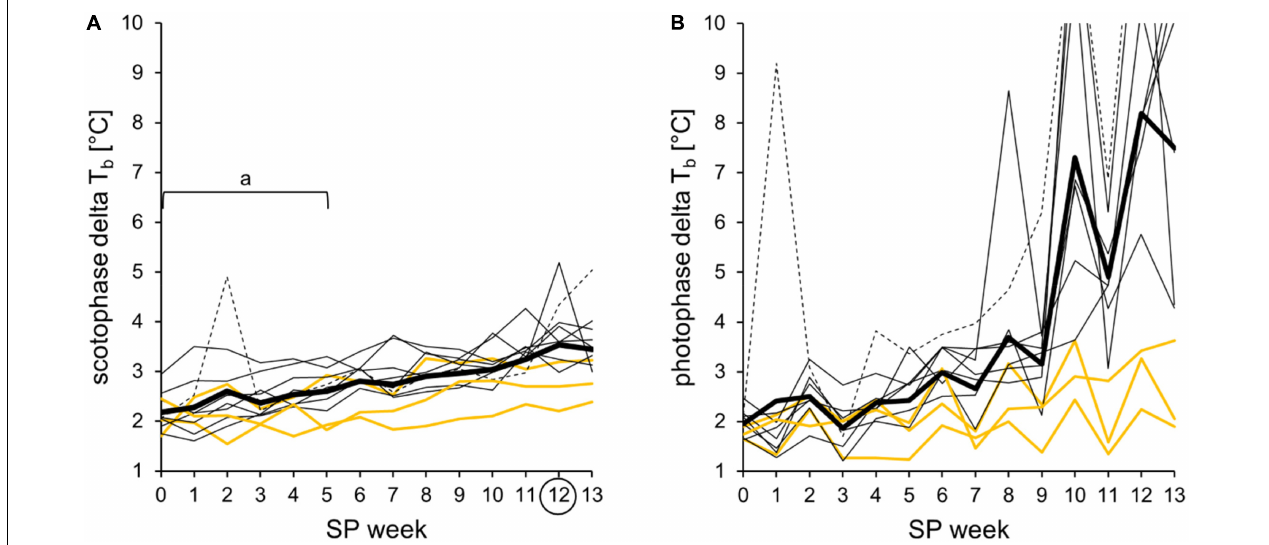
FIGURE 7 | Delta body temperature during the short photoperiod adaptation of approach 2. The difference between the highest value per hour and the lowest value per hour, detected within a time frame, is shown for each animal and week. Hamster #06 is represented as dotted line , the three “never torpor” hamsters as yellow lines , all others as thin black lines , and the cohort’s mean delta body temperature as thick black line . The exact values per hamster can be found in Supplementary Table 5 . (A) Delta body temperature of scotophase. The values per individual were averaged as delta of the cohort ( n = 11, thick line ), which showed a linear development (from SP00 to SP13: R 2 = 0.936, r = 0.967, p < 0.05). For the cohort, significant differences to SP12 are indicated with “ a ” [Friedman repeated measures ANOVA: χ 2